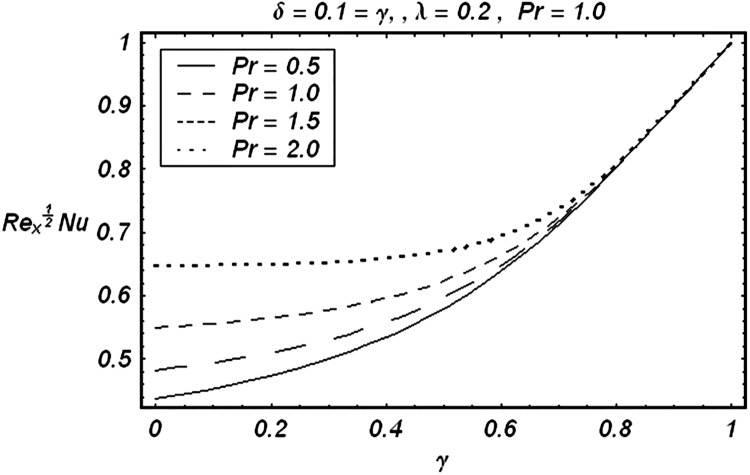
Effect of Pr on local Nusselt number.